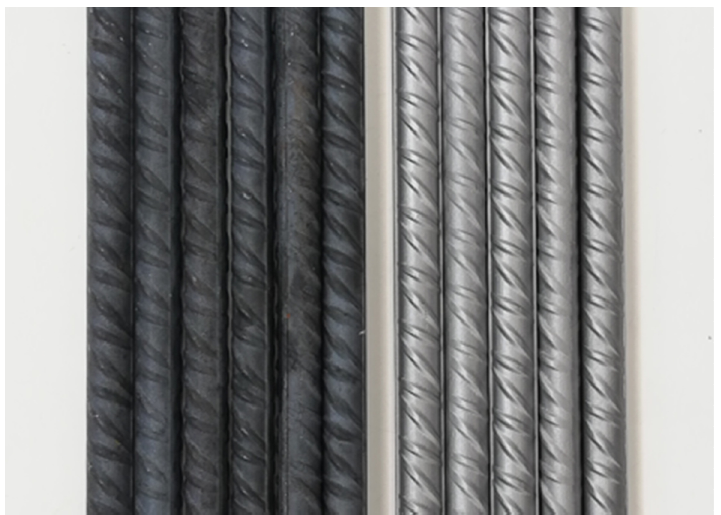
Figure 2. Steel (B500c) reinforcing bars before ( left ) and after ( right ) shot blasting process.